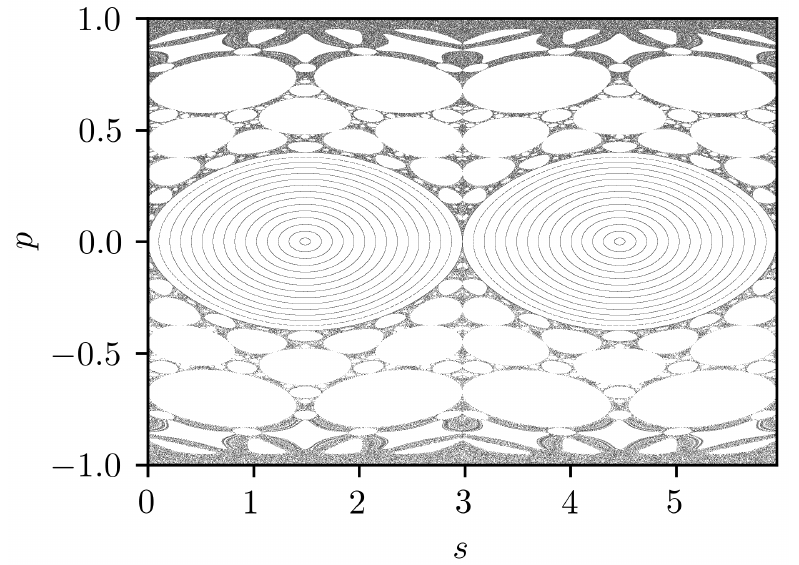
[ 0,5.9508 ] . The parameters are: χ c = 0.2168, ∈